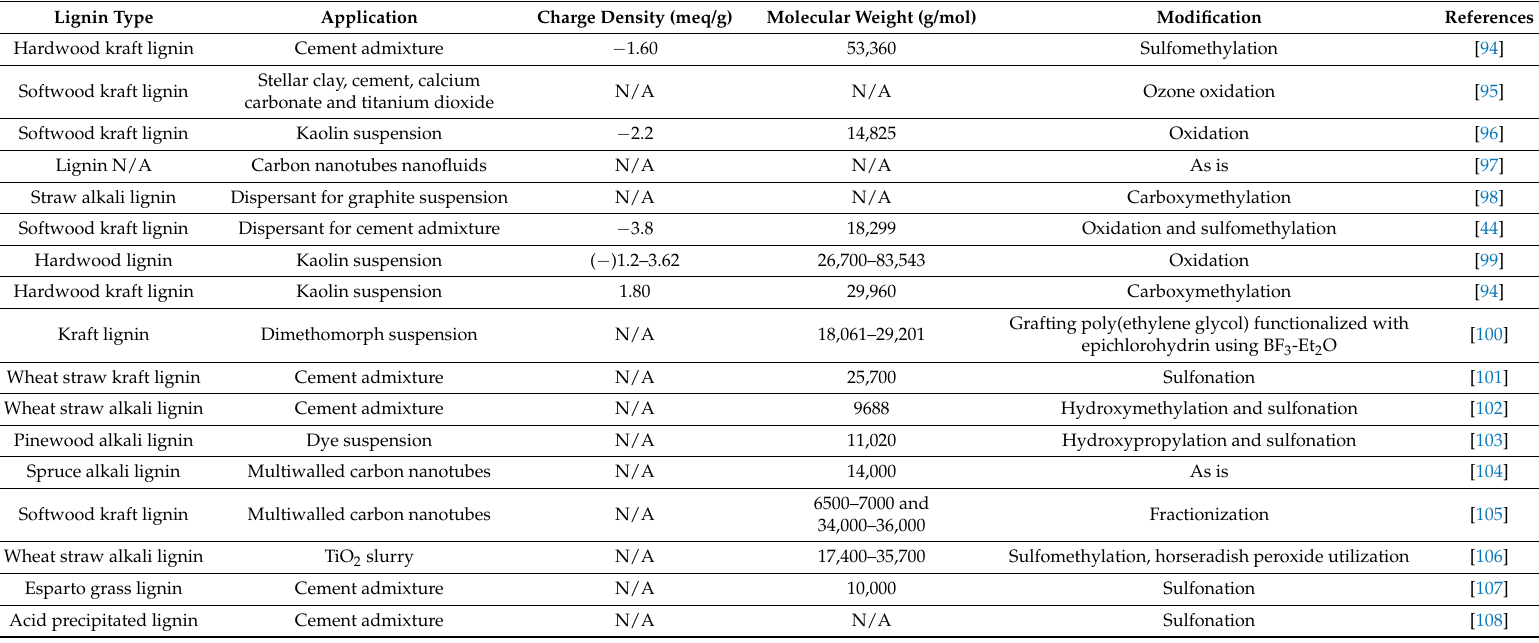
Table 6. Proposed lignin-based dispersants for various